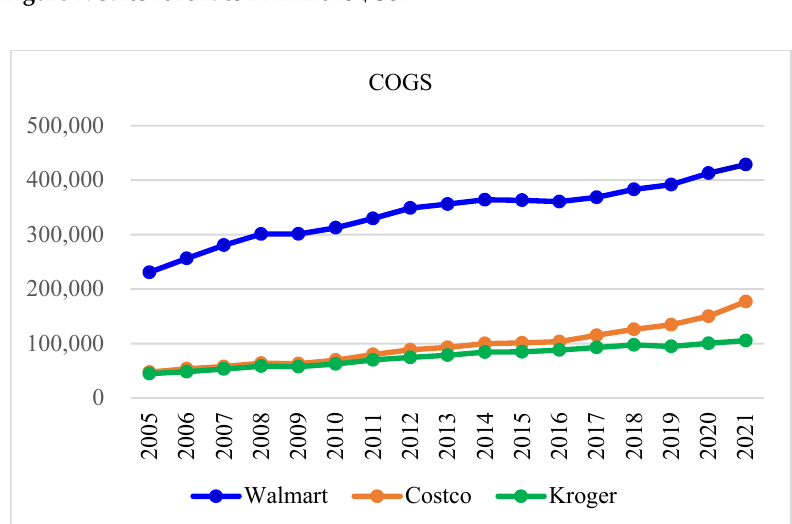
Figure 8. Cost of goods sold (COGS) in millions $USD.